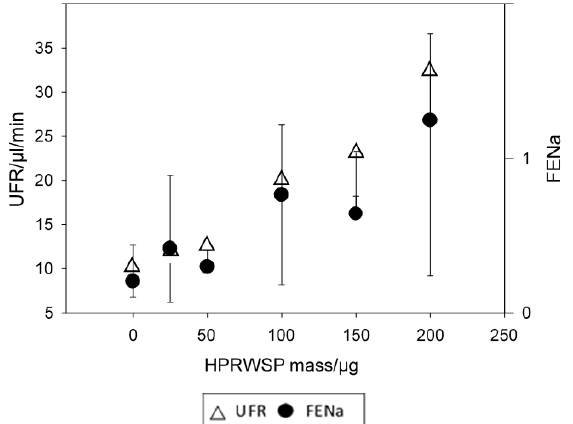
Figure 5. Graph showing the effect of increasing dose of the natriuretic protein, haptoglobin related protein without signal peptide on fractional excretion of sodium (FENa) and urine flow rates (UFR). Note the robust increase in both with increasing doses of the natriuretic protein.